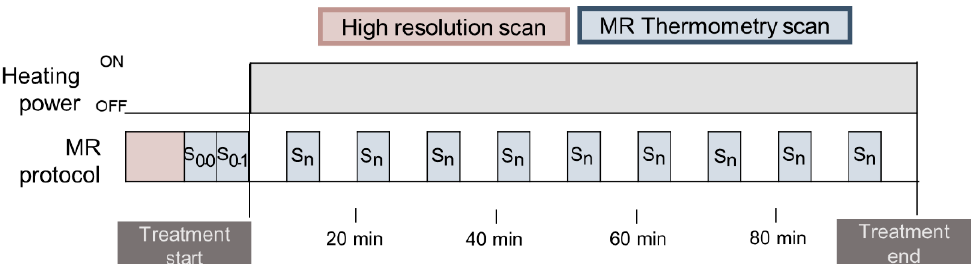
Figure 1. Description of the clinical MR protocol. Each sequence is represented with a color. High- resolution scan and two MR thermometry scans were taken before the treatment, and approximately nine MR thermometry scans were performed during treatment.